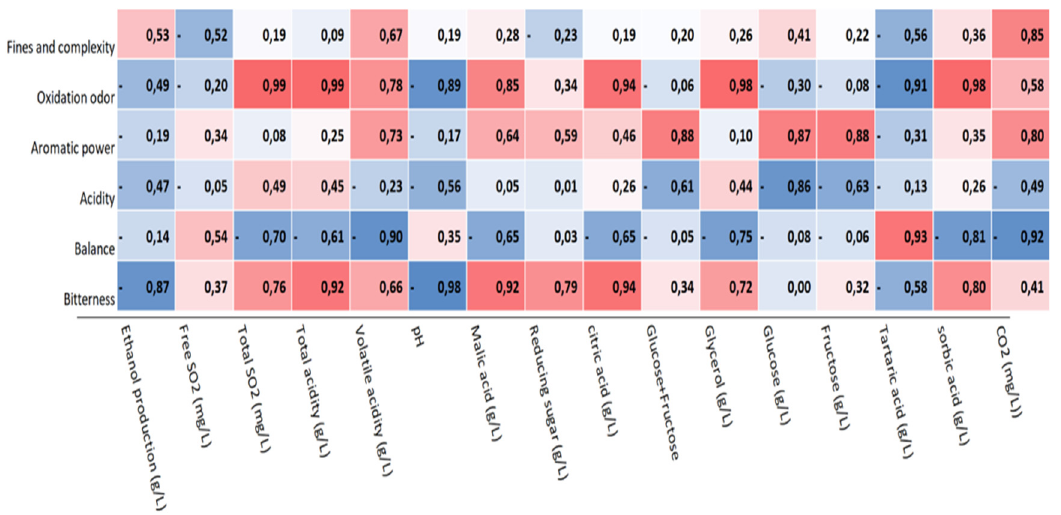
Figure 5. Correlation between the results of the chemical parameters and sensorial perception determined by judges for the tested wines. The color intensity means the grade of correlation (light color: low correlation; intense color: high correlation). The red and blue colors mean positive and negative correlation, respectively.